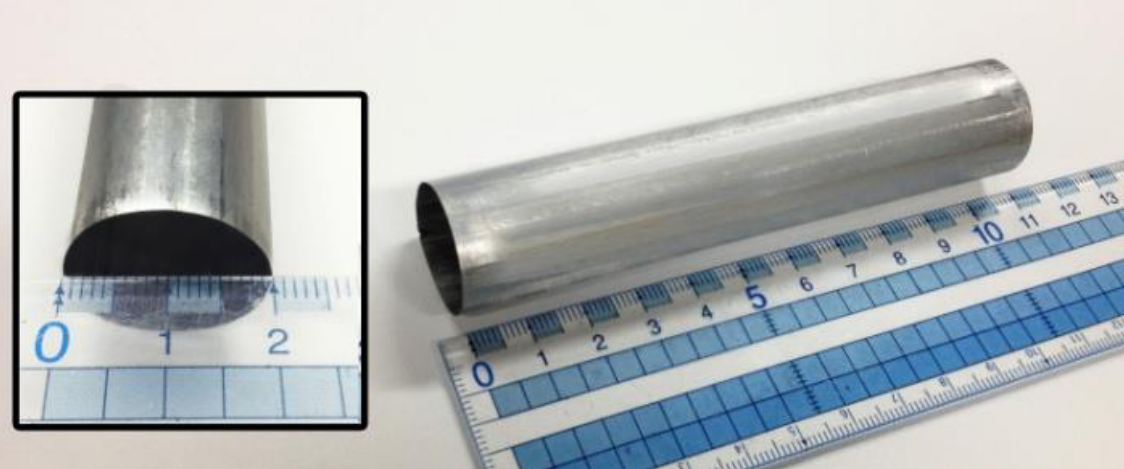
Figure 17. Sample of tube-type Al/Fe–Cr alloy/Al-clad substrate with a diameter of 20 mm.